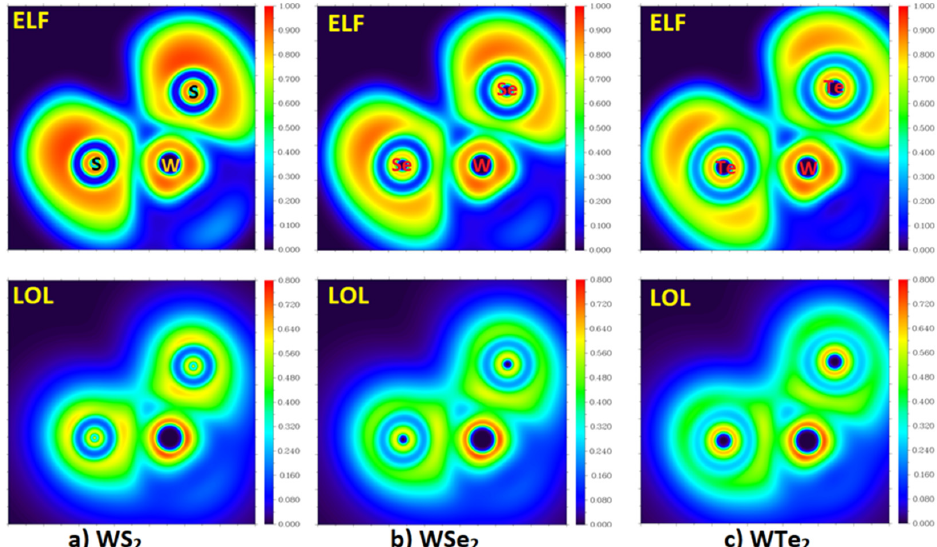
Figure 6. M06-2X/Aug-cc-pVTZ(-PP) level 2D maps of ELF and LOL functions ( Top and Bottom , respectively) obtained on the plane defined by the two Ch atoms and one W atom in isolated WCh 2 (Ch = S, Se, Te) monomers: ( a ) WS 2 ; ( b ) WSe 2 ; and ( c ) WTe 2 .